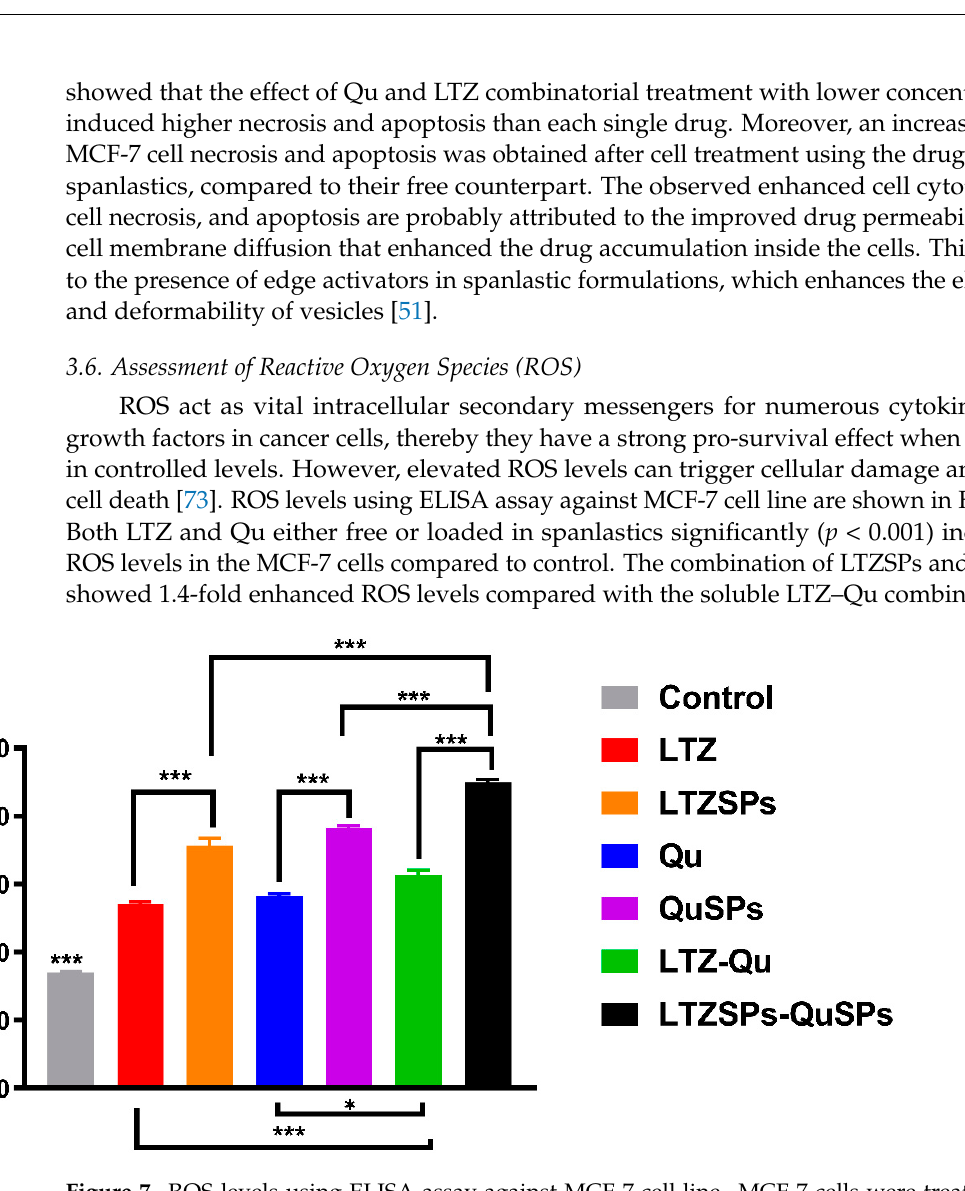
Figure 7. ROS levels using ELISA assay against MCF-7 cell line. MCF-7 cells were treated with selected concentrations of LTZ and Qu and their combination and also LTZ–Qu, LTZSPs, QuSPs and their combination and measured using an ELISA after 24 h of treatment. All samples show significance difference compared to control. Data are expressed as mean ± SD ( n = 3). *** p < 0.001, * p < 0.05. Abbreviations: LTZ; letrozole, Qu; quercetin, LTZSPs; letrozole-loaded spanlastics, QuSPs; quercetin-loaded spanlastics.